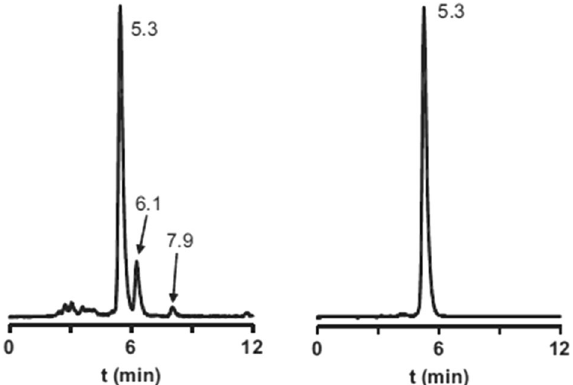
Fig. 5 Radio-HPLC chromatogram of 68Ga-DOTA-TATE with the addition of 10% sodium thiosulfate (Left) and with the addition of 10% ethanol (Right) (Mu et al.